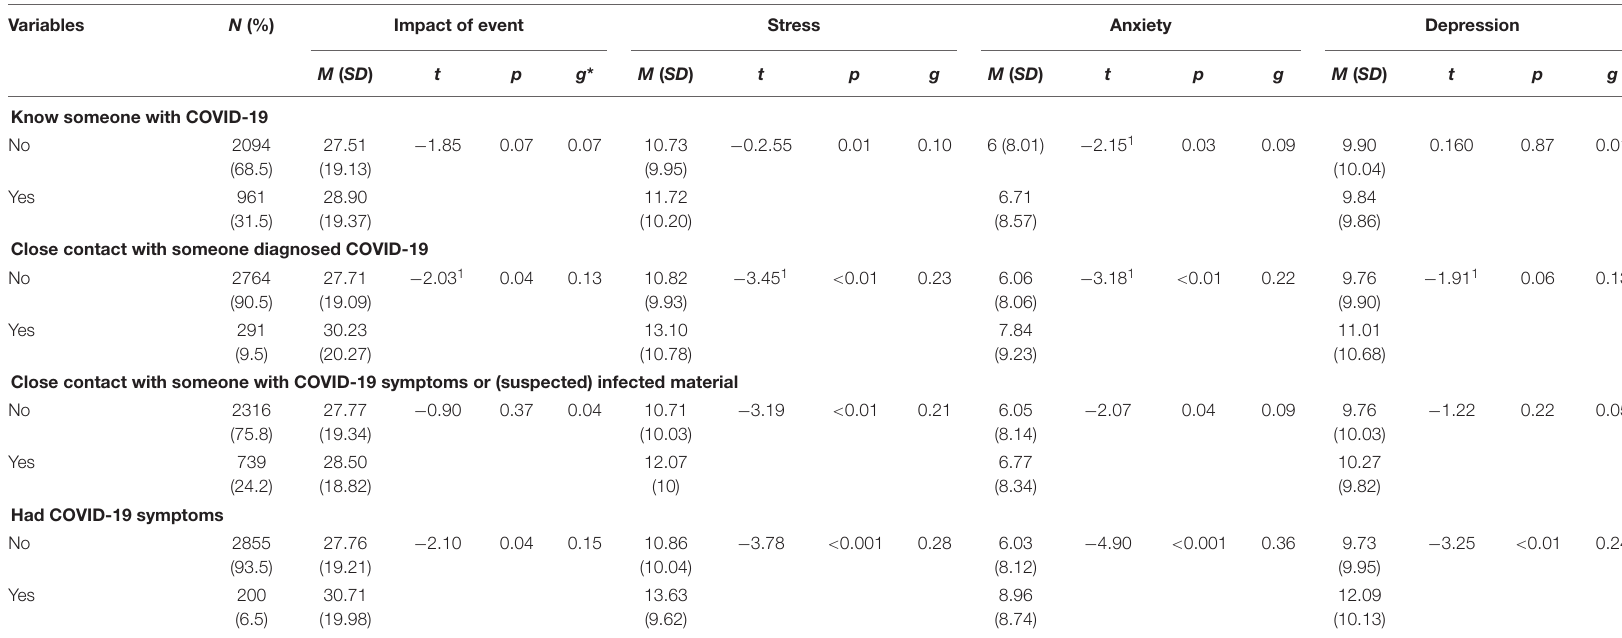
TABLE 7 | Association between the degree of contact with the COVID-19 disease and the psychological impact of the COVID-19 pandemic as well as mental health status during the pandemic ( N = 3055). Variables N (%) Impact of event Stress Anxiety